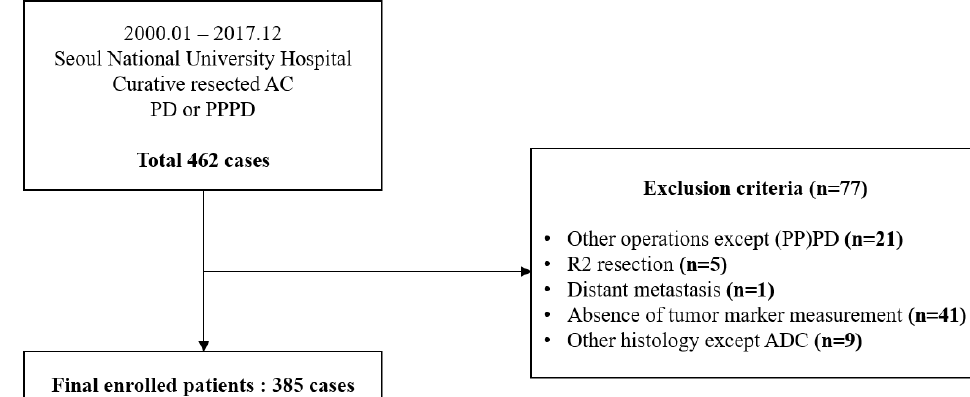
Figure 1. Flow chart of patient